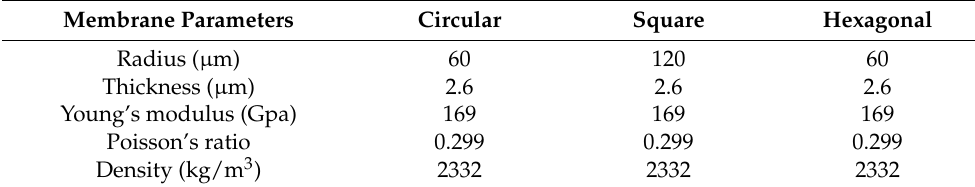
Table 2. Performance parameters of different membrane shapes.